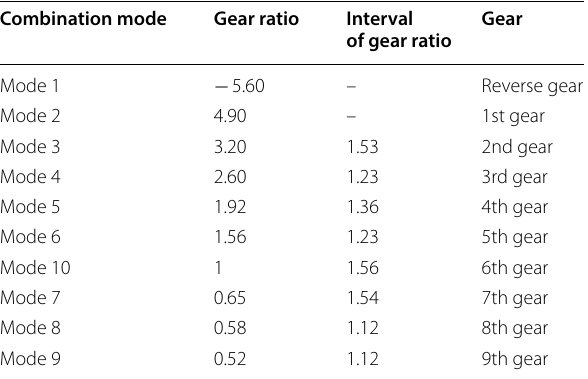
Table 5 Gear ratios, interval of gear ratio and gear ranking of the novel AT mechanism